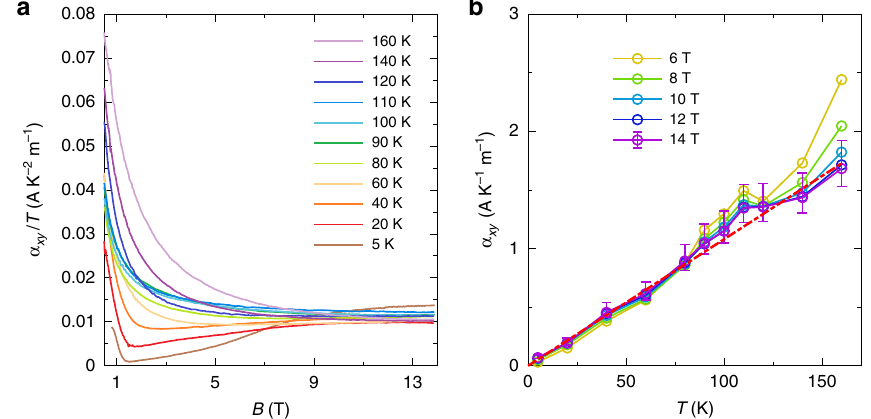
Fig. 3 Transverse thermoelectric conductivity. a α xy ∕ T as a function of B at different temperatures. α xy is independent of B at high fi elds. b α xy as a function of temperature at different fi elds. The red dashed line is a guide to the eye. The error bars indicate one standard error, and re fl ect uncertainties in the measurements of the temperature difference and sample dimensions (see Supplementary Note 1 for detail). For visual clarity, only the error bars for B = 14 T are